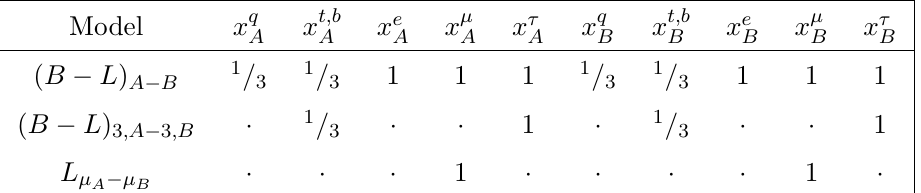
Table 1 . The magnitude of the U(1) X charges of A and B sector fermions for three cases X currents. The superscripts specify the generation, with the (cid:12)rst and second generation quarks denoted collectively by q 2 f u; d; s; c g .